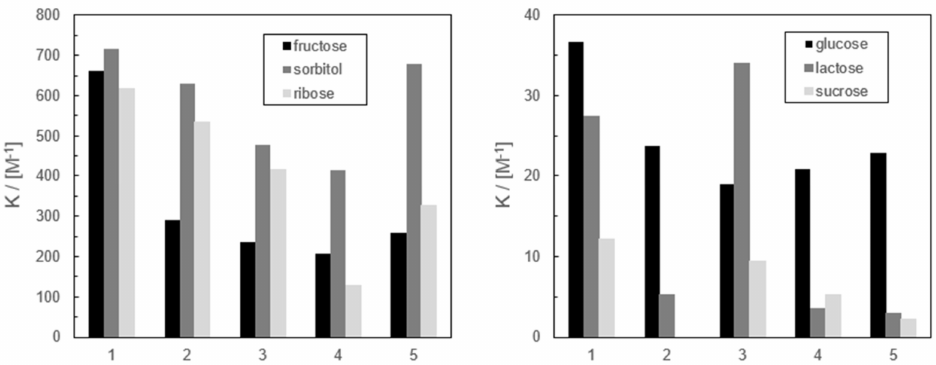
Figure 2. Stability constants of complexes of benzosiloxaboroles 1 – 5 with selected